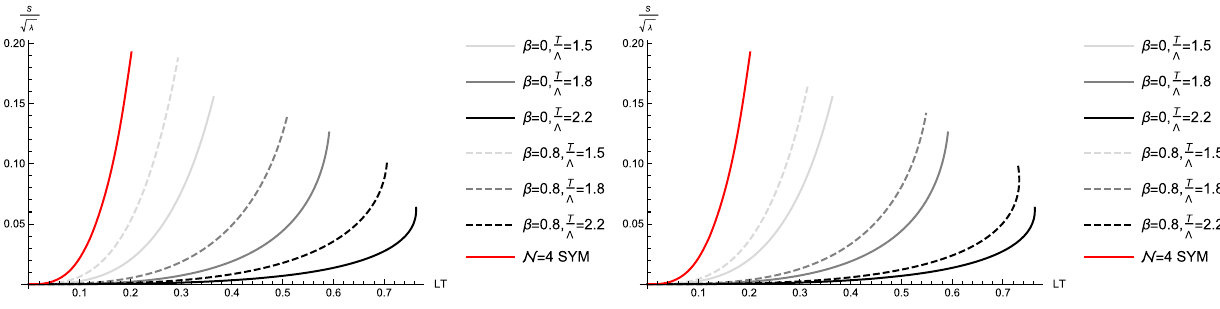
√ λ versus LT in different values of T /(cid:2) and β : Left: (cid:10) = π/ 2, Right: (cid:10) = 0 Fig. 7 The small black hole. S /